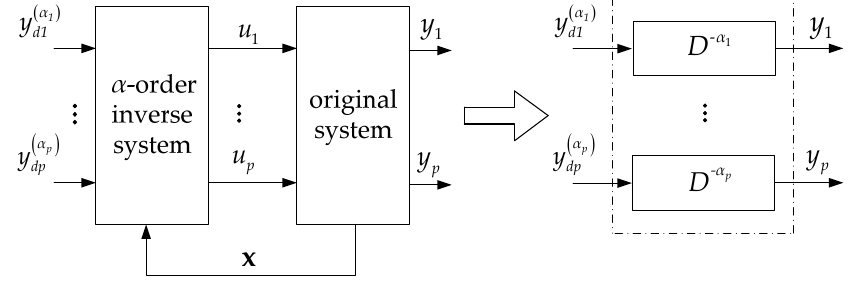
Figure 4. Decoupled linearization based on α ‐ th order inverse system.